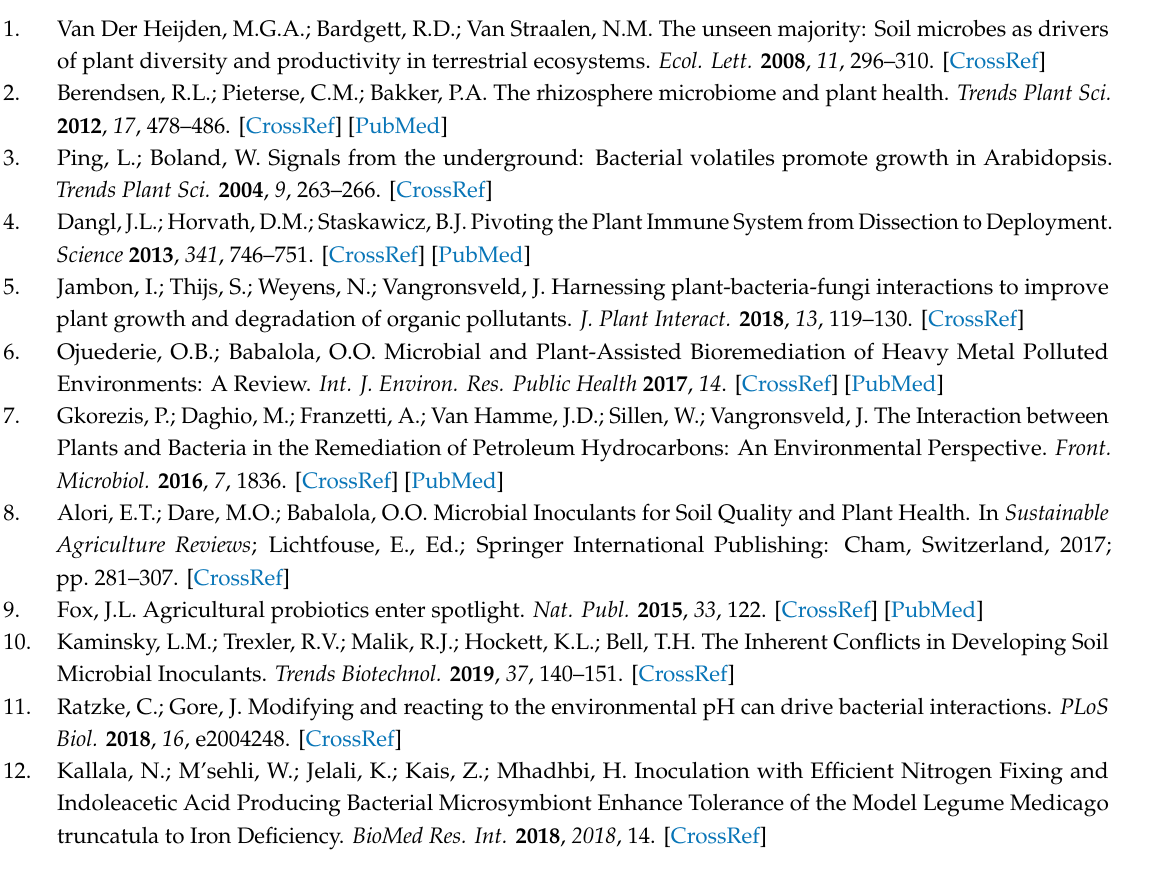
rhizosphere and those without the "z" represent root samples. Table S4: ANOVA analysis output from JMP for Shannon’s index. Table S5: ANOVA analysis output from JMP for the Chao1 diversity index. Table S6: ANOVA analysis output from JMP for Pielou’s equitability index. Table S7: Permanova analysis of the AMF communities based on the Bray-Curtis dissimilarity matrix. Table S8: ANOVA analysis output from JMP for the plant dry biomass production. Table S9: ANOVA analysis output from JMP for AMF root colonization percentages. Figure S1: Planting scheme in each tray (A), experimental setup (B), and a comparison between the non-contaminated soil and contaminated sediments mesocosms (C). Figure S2. Plant sampling example from a Persicaria lapathifolia . Figure S3. Bayesian phylogenetic tree based on nuclear small subunit (SSU) rDNA consensus sequences showing the distribution of the 23 OTUs recorded in this experiment (red labels) among the Glomeromycota tree.Sequence data were analyzed with the SSU sequences (black labels) from Krüger et al. (2012) and the closest matches recovered from MaarjAM database. The numbers on the nodes represent the Bayesian posterior probabilities. The scale represents the branch length corresponding to expected substitutions per site. Figure S4. Mycorrhizal structures observed in the plant roots under light